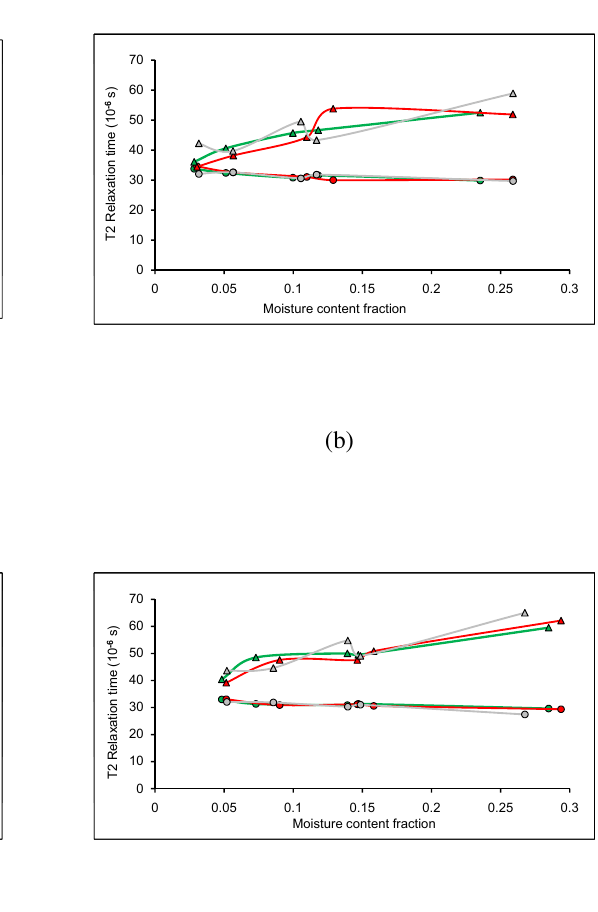
water T s. 2 Figure 2. Spin-spin relaxation time (T ) analysis for mountain pine beetle affected lodgepole 2 pine, where the circles correspond to the relaxation time from the gaussian broadened sinc function, the triangles correspond to the relaxation time from the gaussian function, and the squares correspond to the relaxation time from the exponential function. The colours correspond to the stage of attack; unaffected (green), red stage (red), and grey stage (grey). (a) T values for wood conditioned in adsorption; (b) Magnification of scale from (a); (c) 2 T values for wood conditioned in initial desorption; (d) Magnification of the scale from (c). 2 The standard error on the points was negligible compared to the size of the symbols used to represent the